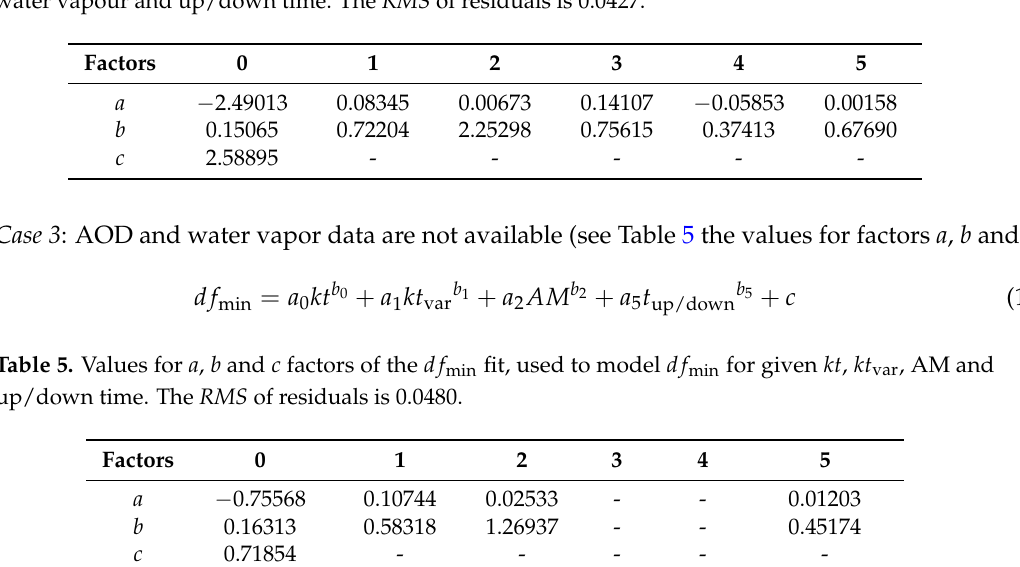
Table 4. Values for a , b and c factors of the df min fit, used to model df min for given kt , kt var , AM, AOD, water vapour and up/down time. The RMS of residuals is 0.0427.